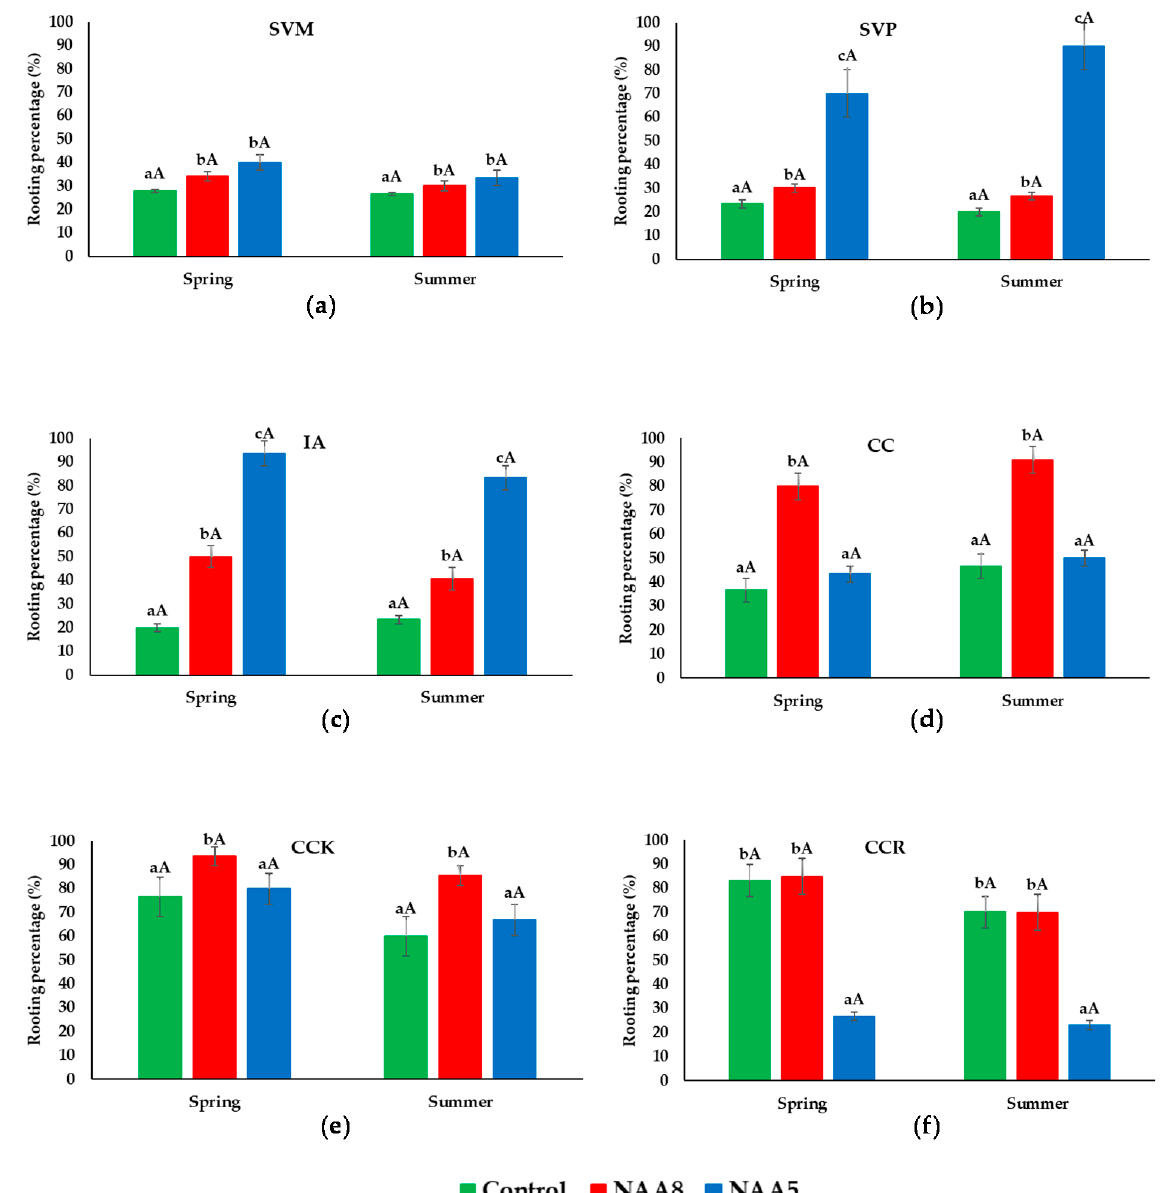
Figure 1. Effect of rooting stimulants (NAA8—0.8% concentration of 1-Naphthylacetic acid and NAA5—0.5% concentration of 1-Naphthylacetic acid) on rooting percentage for the six selected ornamental shrubs: ( a ) Syringa vulgaris ‘Mme Lemoine’ (SVM); ( b ) Syringa vulgaris ‘President Grevy’ (SVP); ( c ) Ilex aquifolium (IA); ( d ) Cotinus coggygria (CC); ( e ) Cotinus coggygria ‘Kanari’ (CCK); ( f ) Cotinus coggygria ‘Royal Purple’ (CCR). Bars represent the means ± SE ( n = 30). Different lowercase letters above the bars indicate significant differences between the treatments, and different uppercase letters indicate the significant differences between the spring and summer propagated cuttings, according to Tukey’s test ( α = 0.05).